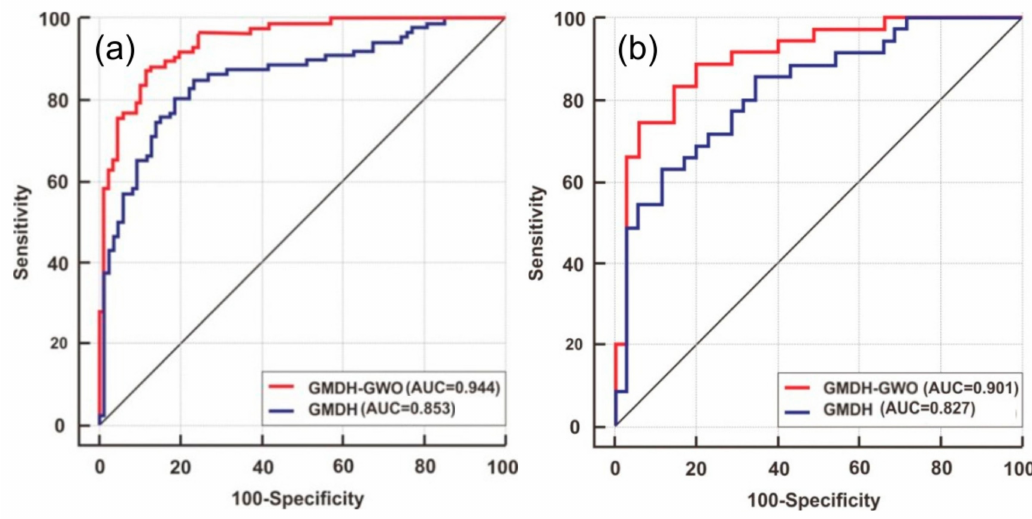
Figure 6. Model performance evaluation: ( a ) Training phase; ( b ) Testing phase.